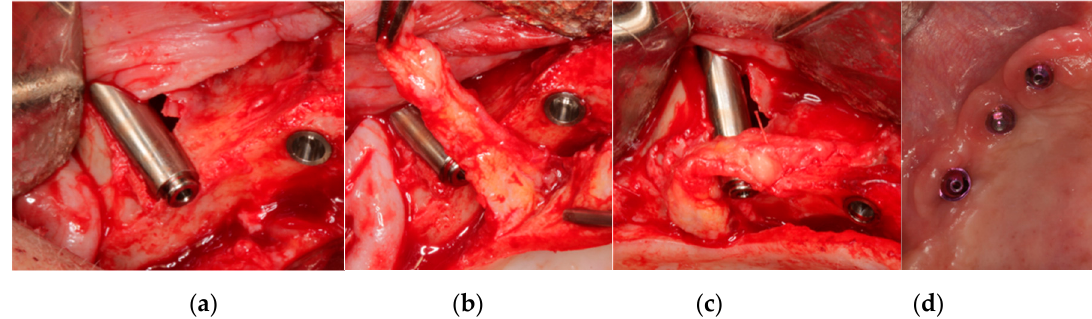
Figure 2. ( a ) Buccal bone dehiscence present in a zygomatic implant with a smooth neck surface (IPX-Tilted System, Smooth, Galimplant S.L., Sarria, Galicia, Spain). More than half of the implant diameter outside the alveolar bone crest. ( b ) Pediculate subepithelial tissue palatal rotation graft. ( c ) Mesial and distal fixation of the soft tissue graft through suture. ( d ) Clinical image of soft tissue healing at 6 months after implant